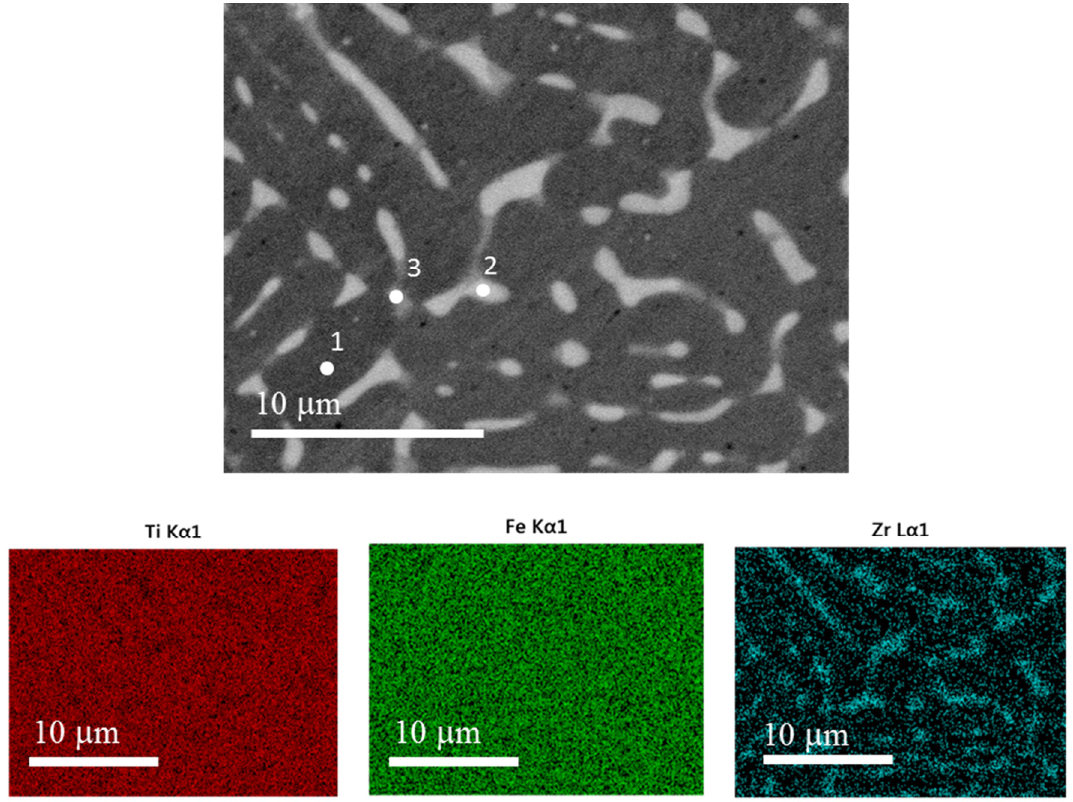
Figure 8. Secondary electron micrograph and EDX mapping of TiFe + 4 wt.% Zr single ‐ melt alloy. Numbers in the first image indicate specific points reported in Table 3. Table 3. Atomic abundance at specific points as measured by EDX of TiFe + 4 wt.% Zr single ‐ melt alloy. Error of each number is indicated in parentheses.